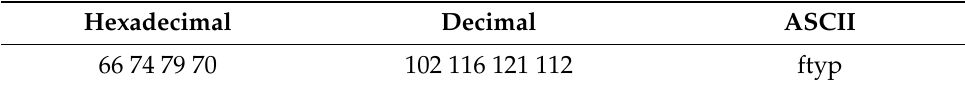
Table 1. Signature type of MP4